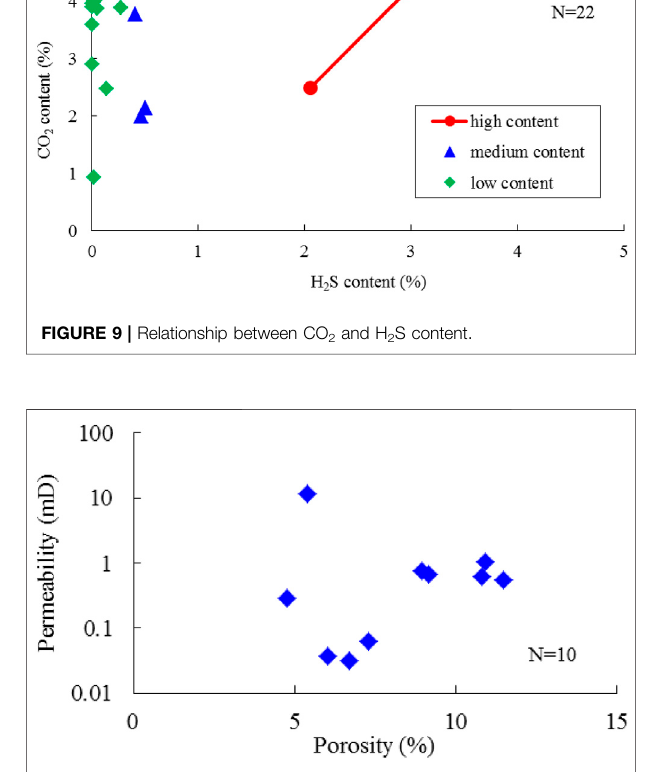
FIGURE 10 | Porosity and permeability of core samples.